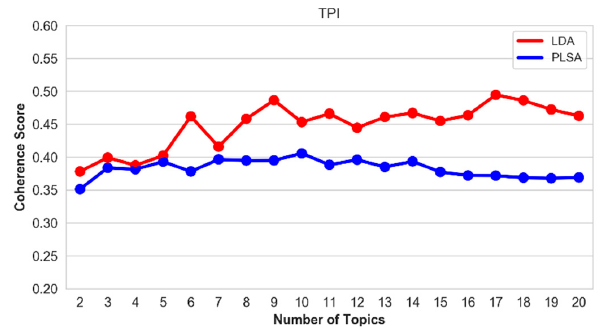
Figure 18. Coherence score of the top-20 topics on the GIM hallmark.